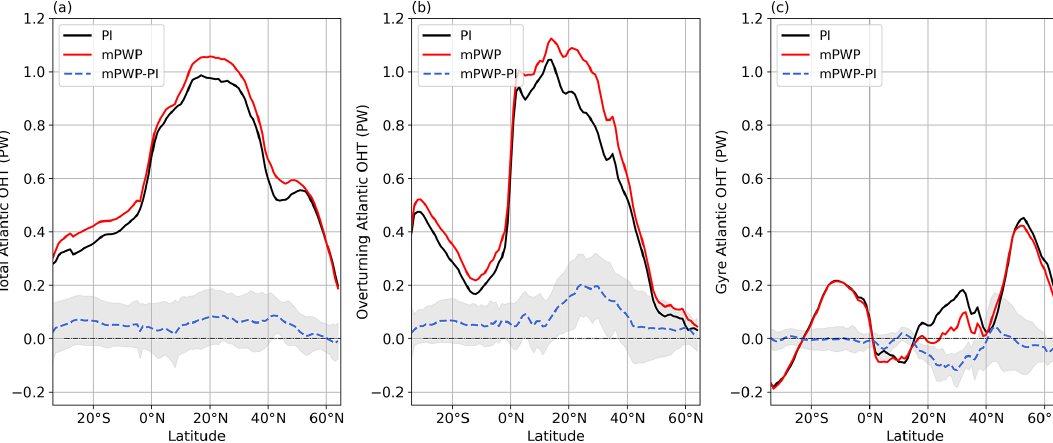
Figure 10. (a) MMM total Atlantic Ocean heat transport in the mid-Pliocene and pre-industrial and the difference. (b) MMM Atlantic Ocean heat transport by overturning. (c) MMM Atlantic Ocean heat transport by wind-driven gyres. The shading indicates 1 standard deviation by individual models from the